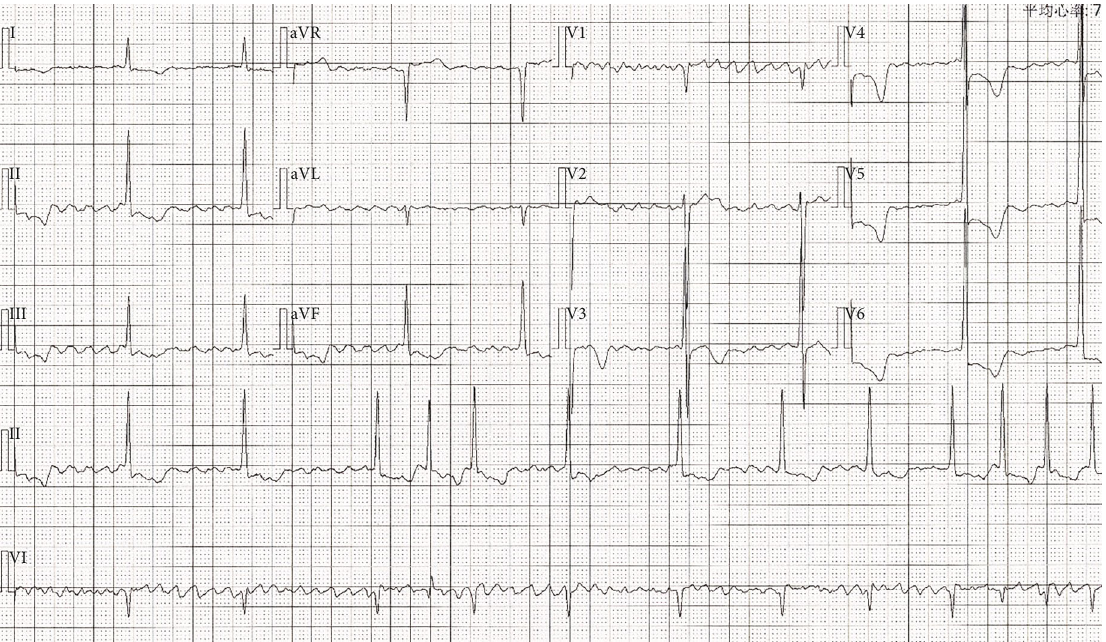
Figure 1: Electrocardiogram. No visible P waves and an irregularly irregular QRS complex showed atrial fi brillation.